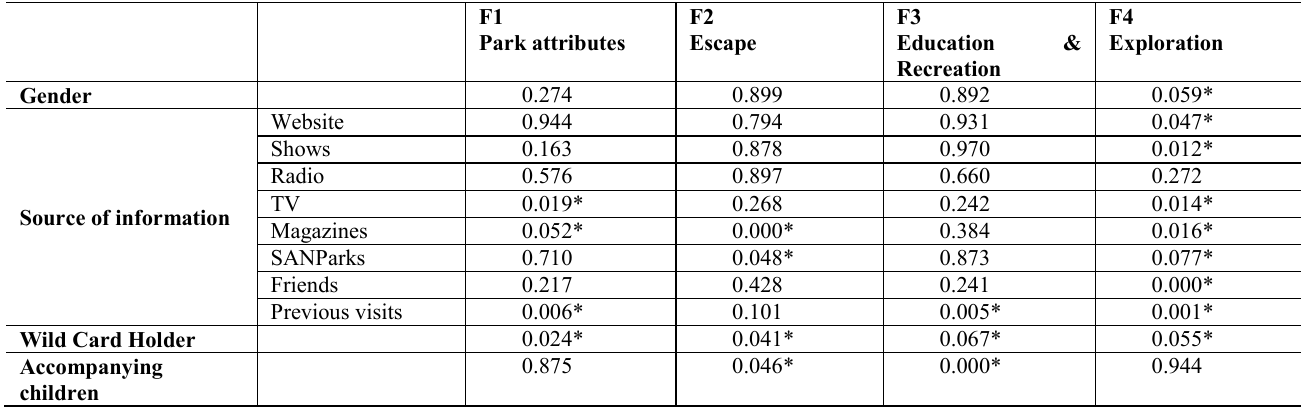
Table 4: T-test for equality of